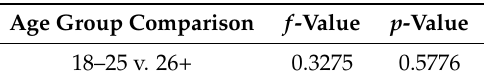
Table 7. Calculated ANOVA score for top words used among age groups to define visual privacy.